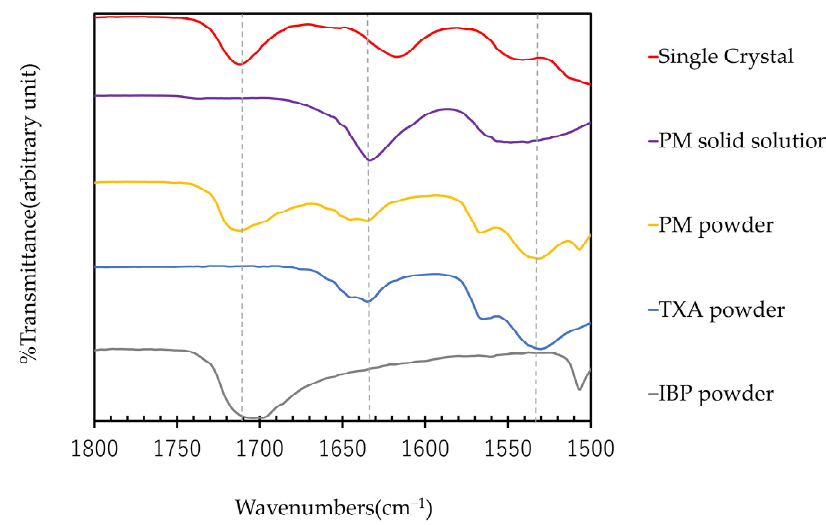
Figure 6. ATR-FTIR spectra of IBP, TXA, PM, PM solid solution, and single